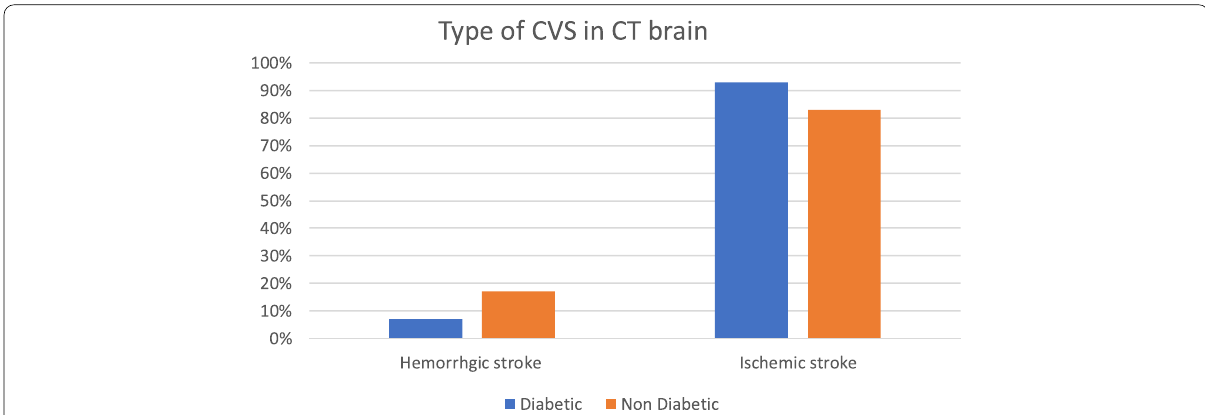
Fig. 1 Comparison between the two studied groups according to type of CVS in CT brain